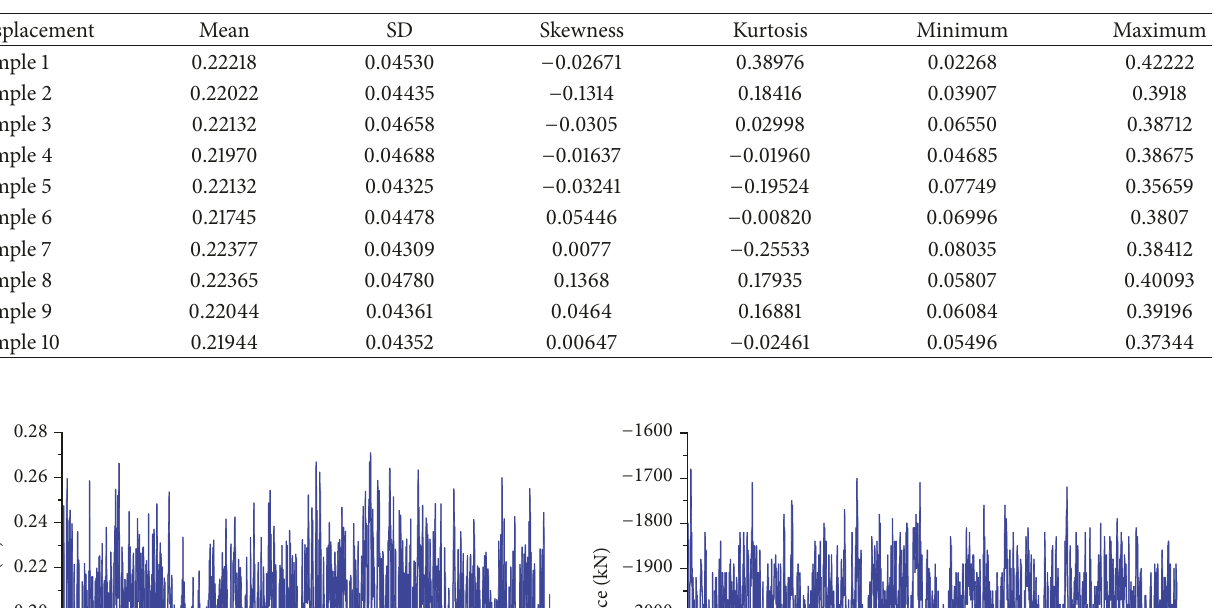
Table 10: Statistics of 10 samples parameters of the single low tower top node 874# Ux displacement time history under wind field 1 (m).